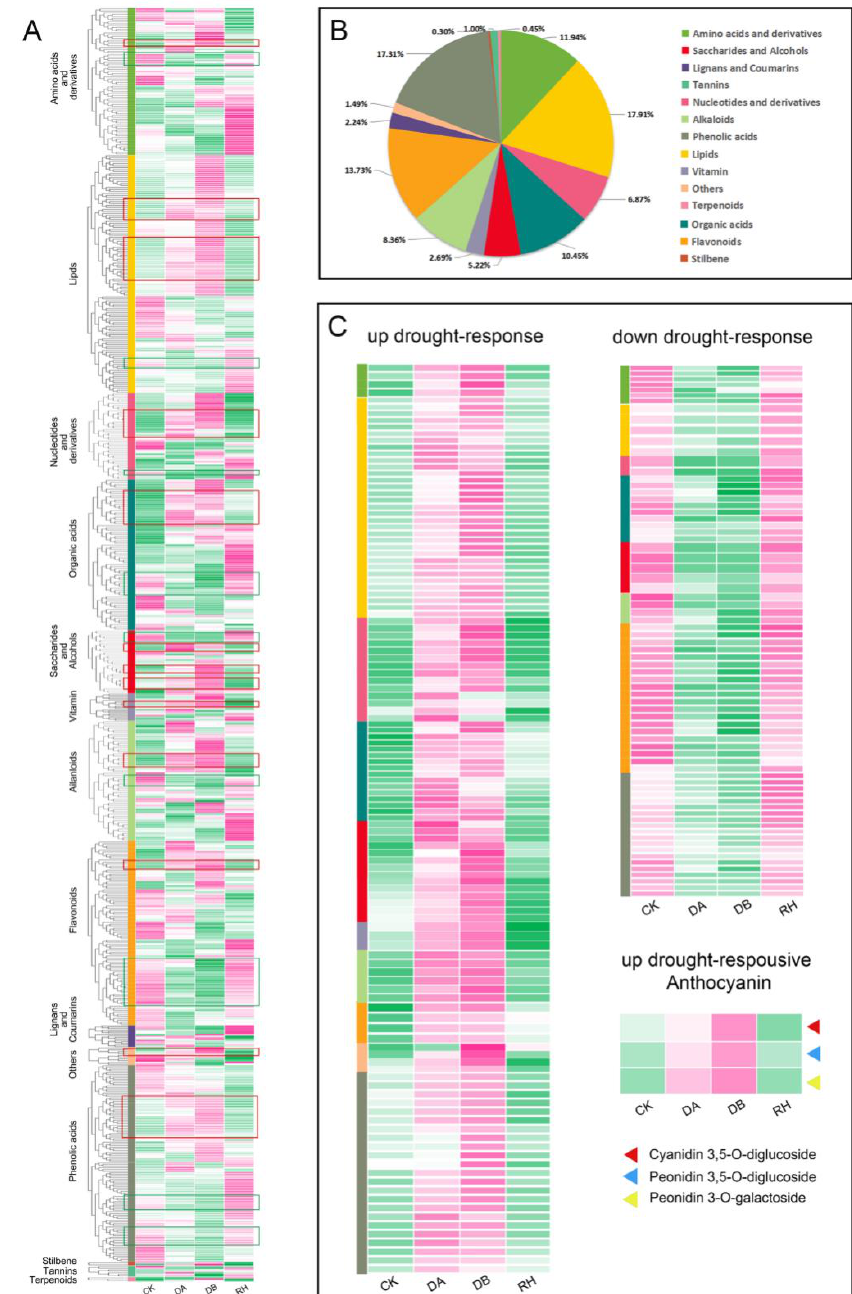
Figure 3. Analysis of metabolite profiles of ‘Qiuhong’ leaves under four different treatments. ( A ) Heat map visualisation of 14 categories of metabolites. The content of each metabolite was normalised by Z-transformation. ( B ) Pie graph representing the percentage composition of the 14 metabolite categories. ( C ) Drought responsive metabolites; the drought-induced anthocyanins are highlighted at the bottom right. The metabolites in red and green rectangles in ( A ) correspond to up- and downregulated drought-responsive metabolites in ( C ), respectively. Data were plotted by TBtools (Toolbox for biologists) V0.67.